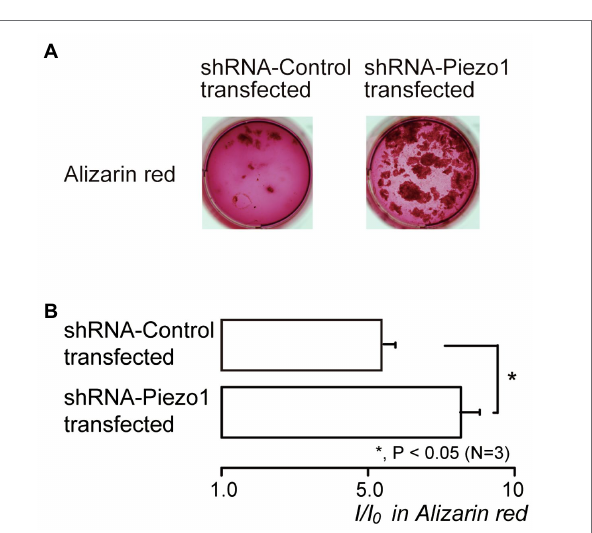
FIGURE 7 | Piezo1 channel knockdown by shRNA enhances the mineralization levels. (A) Human odontoblasts transfected by shRNA including a vector specific for human Piezo1 (right; shRNA-Piezo1 transfected) or including an empty vector control (left; shRNA-Control transfected) were cultured for 28 days in mineralization medium, and subjected to the Alizarin red staining (red indicative of calcium deposition). (B) The mineralization levels in the cells of shRNA-Control transfected (upper column) and shRNA-Piezo1 transfected (lower column), assessed by Alizarin red staining. The mineralization levels were 5.95 ± 0.36 I / I 0 in the shRNA-Control transfected cells, and 8.30 ± 0.59 I / I 0 in the shRNA-Piezo1 transfected cells. Each column indicates the mean ± SE from three experiments. Statistically significant differences between columns (solid line) are indicated by asterisks. * p < Piezo1 channels in odontoblasts may negatively regulate not only reactionary dentinogenesis induced by cell membrane deformation due to dentinal fluid movements by the stimuli applied to the exposed dentin surface, but also physiological/ developmental dentinogenesis. In contrast, the activation of mechanosensitive- and high-pH sensitive-TRPA1 channels in odontoblasts positively modulates mineralization in physiological, developmental, and pathological conditions [e.g., Ca(OH) 2 or mineral trioxide aggregate (MTA) application on dentin; Kimura et al., 2016]. Although further studies are needed, these convergent results suggest that, among odontoblast-expressing mechanosensitive cation channels, including TRPV1, TRPV2, TRPV4, TRPA1, and Piezo1 channels, their functional roles in sensory transduction and dentin formation are different.